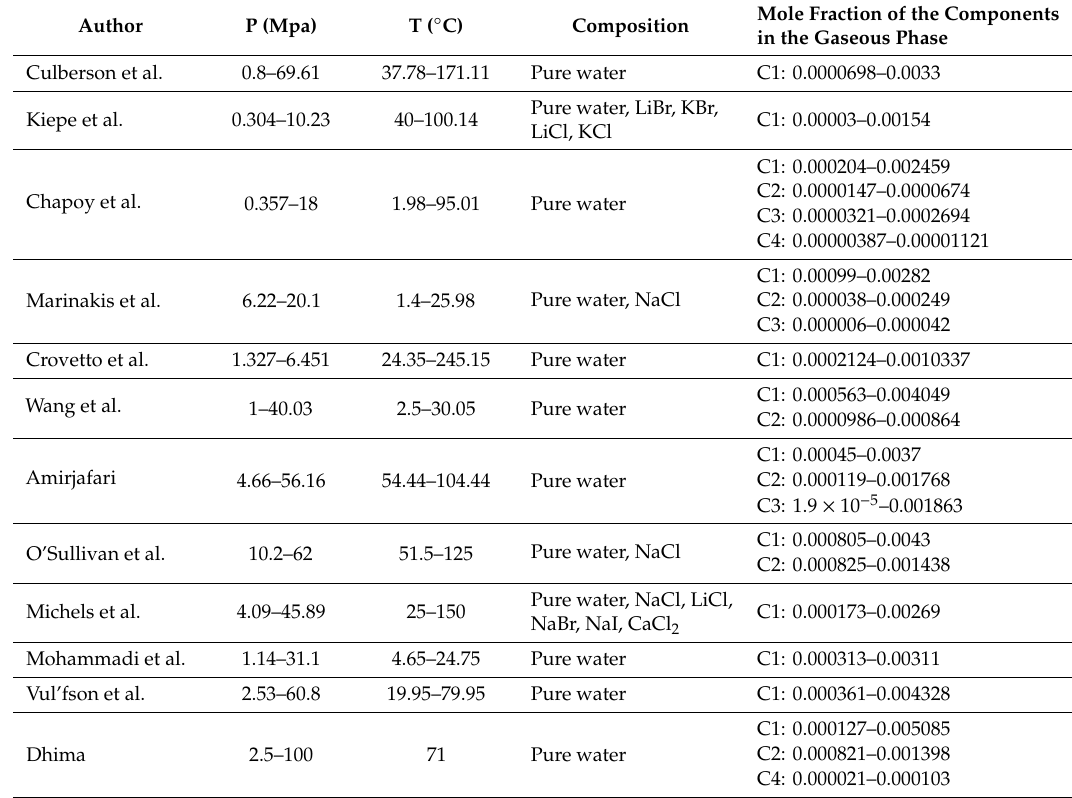
Table 1. Details of experimental hydrocarbons solubility in aqueous electrolyte